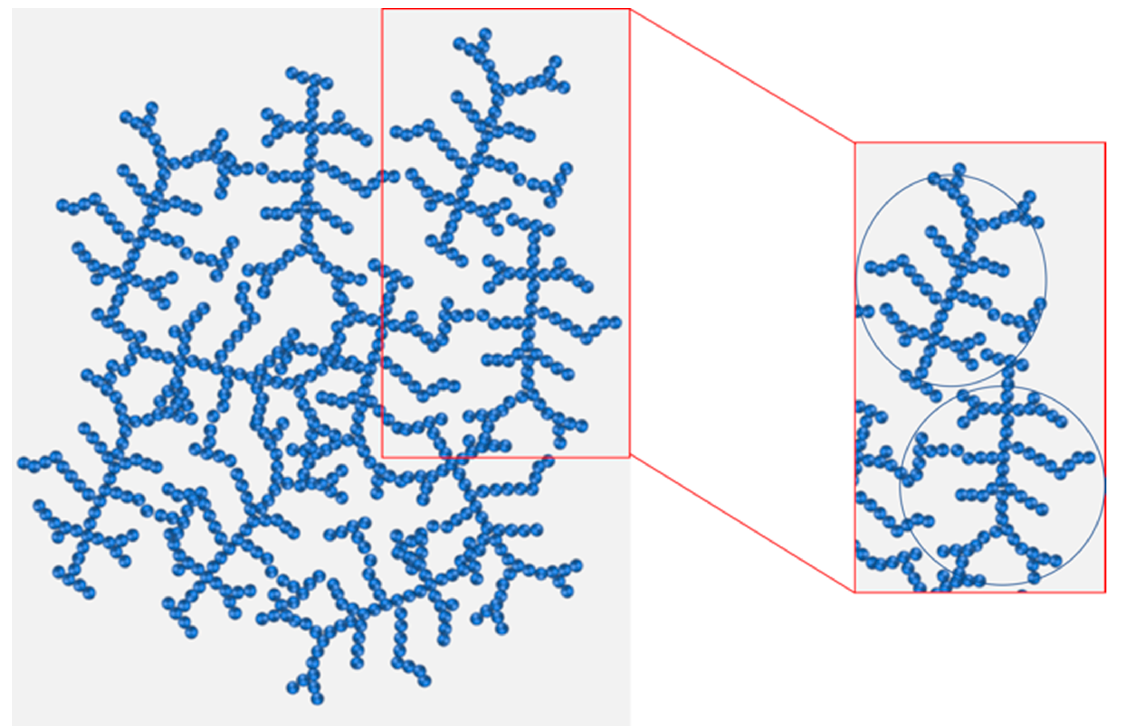
Scheme 1. Schematic representation of an agglomerated microgel dispersion ( left ) and the for- mation of microgels’ fractal flocs or agglomerates ( right